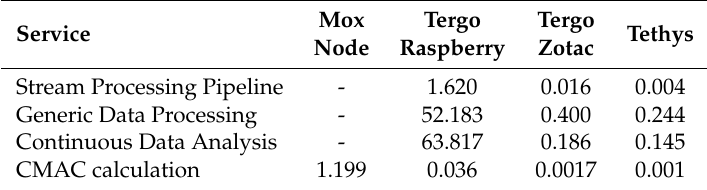
Table 5. Services’ processing latency